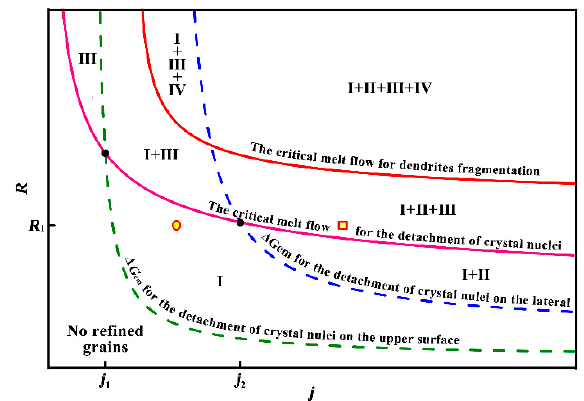
Figure 12. Schematic summary of the origin of FEG in pure aluminum under electropulsing. For the origin of FEG, I, III and IV represent the dissociation of crystal nuclei on the upper interface of the electrode and the melt due to ∆ G em , the dissociation of crystal nuclei on the side wall due to ∆ G em , the dissociation of crystal nuclei due to melt flow and dendrite fragmentation, respectively.